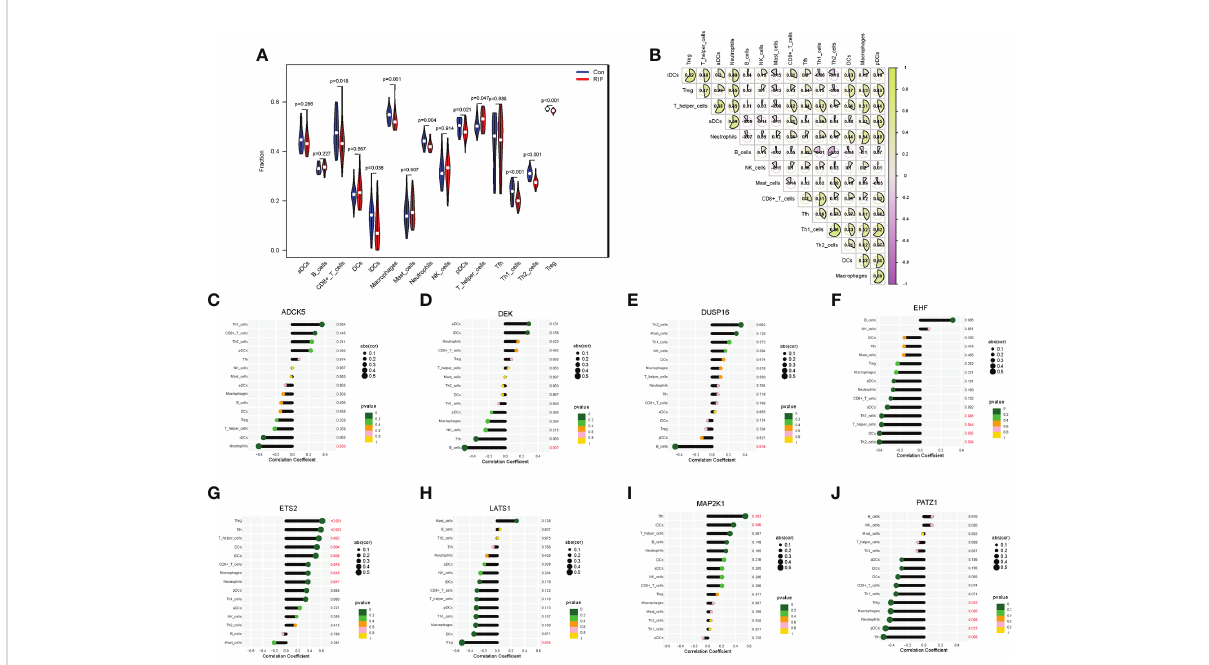
FIGURE 5 Immune cell in fi ltration landscape of RIF and its correlation with the RIF signature genes. (A) The distribution of immunocytes between the RIF and control samples. (B) The correlation heatmap showed the correlation between different immunocytes in RIF samples. ( C – J ) The lollipop chart showed the correlation between RIF signature genes and immunocytes in RIF